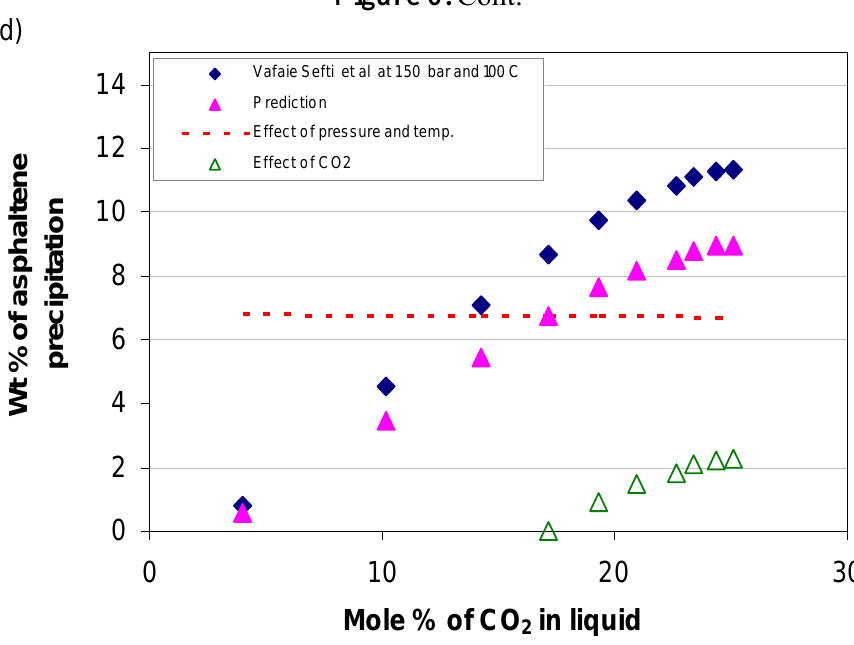
flooding (well stream 2